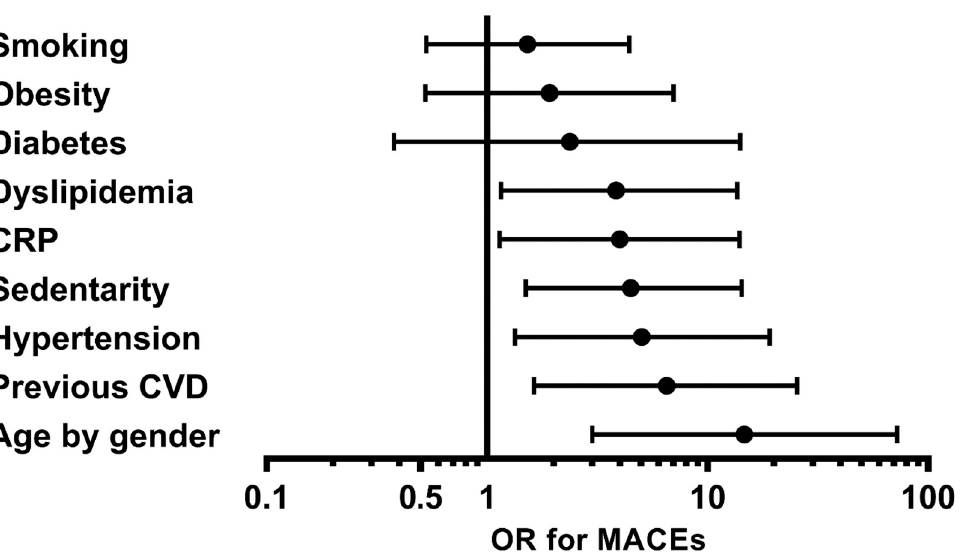
Figure 1. Odds ratios of presenting a major cardiovascular event during follow-up for each cardiovascular risk factor and CRP from the OSTEOVAS cohort. The multivariate analysis was adjusted for the use of glucocorticoids and cyclophos- phamide. CRP, C-reactive protein; CVD, cardiovascular disease; OR, odds ratio; MACEs, major cardiovascular events; age by gender: being >50 years for men and >60 years for women. Table 4. Factors associated with the occurrence of major cardiovascular events during the follow-up found in the multivariate analysis of the OSTEOVAS